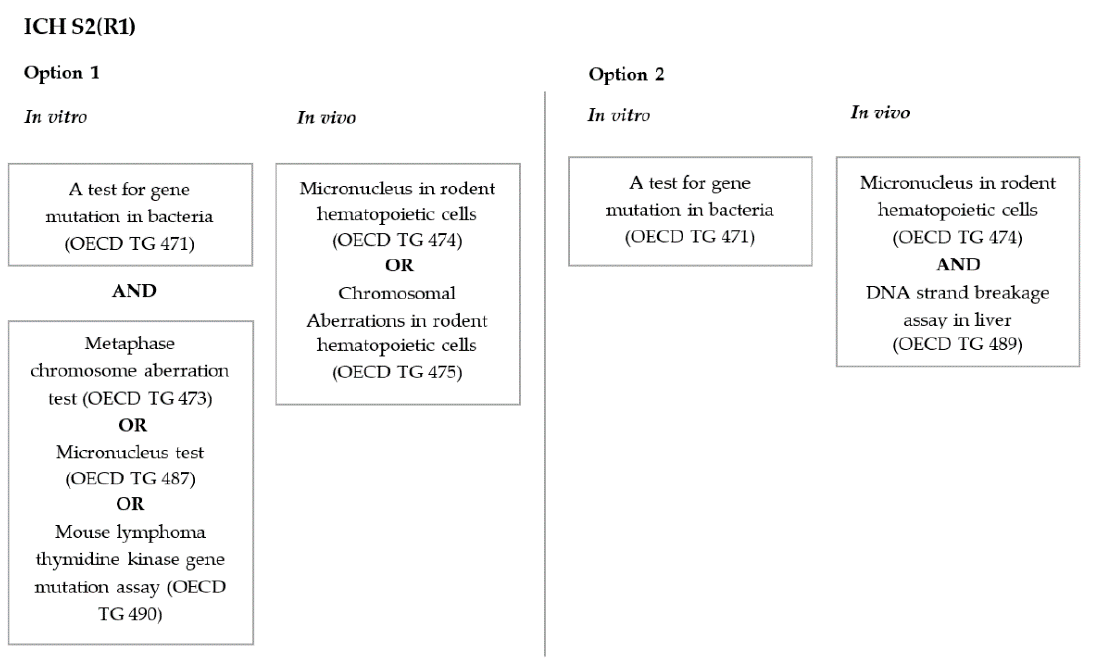
Figure 1. Scheme of the ICH S2(R1) strategy for a genotoxicity assessment.